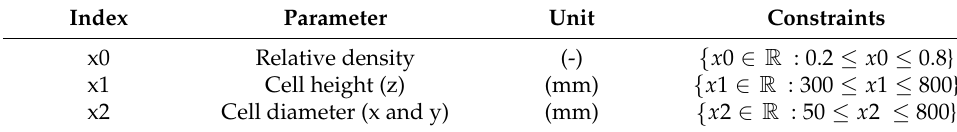
Table 3. Parameter allocation for the parametric optimization of the cellular